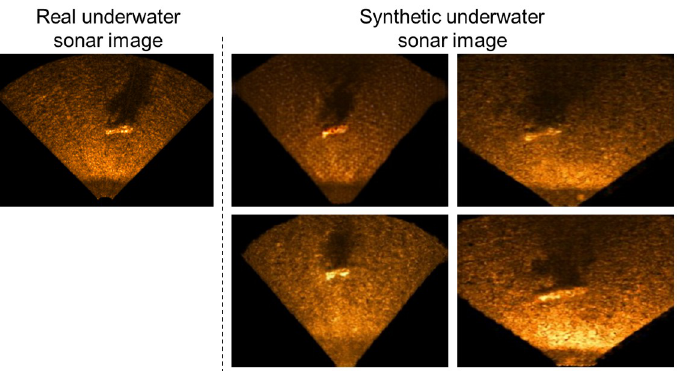
Fig 5. Real USI and USIs generated by the generator after training the image translation NN. The generator of the image translation can create USIs of the object with various poses and lighting conditions, which do not exist in the training